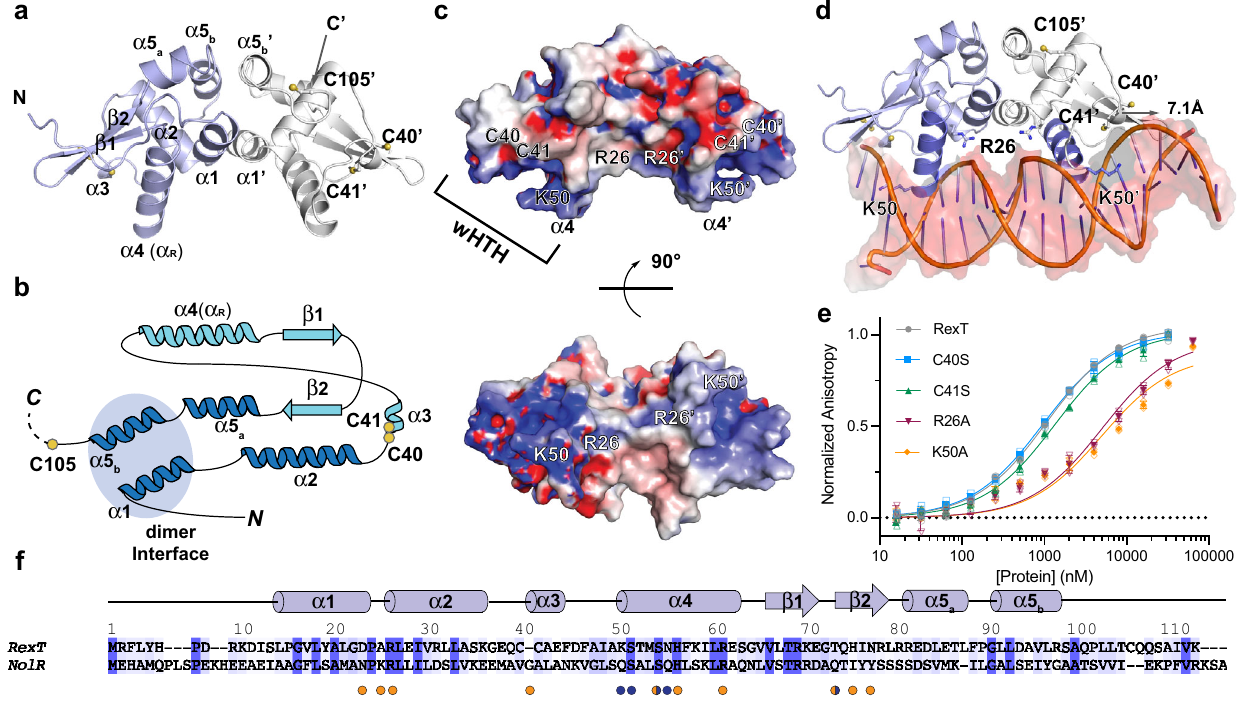
Fig. 2 RexT has an ArsR-SmtB-type winged helix-turn-helix fold. a The crystal structure of RexT reveals that it is a homodimer. Each protomer of RexT has an α 1- α 2- α 3- α 4- β 1- β 2- α 5 a/b architecture. Chains A and B are colored in light blue and light gray, respectively. Two of the three potential redox sensing Cys residues are located on the α 3 helix (Cys40 and Cys41). Due to the dynamic nature of the residues following Cys105 in chain B, residues 106 – 112, like residues 102 – 112 in chain A were unable to be included in the fi nal model of RexT. b A topology diagram of RexT shows the position of the three Cys residues (yellow circles), the dimeric interface (blue circle), and the wHTH motif (light blue secondary structure). c The calculated electrostatic potential of RexT reveals positively charged patches. The two-Cys residues and two positively charged residues that are proposed to be involved in DNA-binding are highlighted. d RexT is shown overlaid with a DNA-bound NolR structure 32 (PDB: 4ON0, RexT is shown with DNA from the NolR structure following an alignment performed in PyMol). This overlay reveals potential residues involved in interacting with DNA and showcases that a complementary interaction can be formed between the positively charged region of RexT and the negative backbone of DNA. In each monomer, α R is colored in dark purple. e A labeled DNA probe shows changes in fl uorescence anisotropy following the addition of RexT. These differences allowed for the calculation of the DNA binding af fi nity of wild-type RexT and the different variants used in this work (Supplementary Table 2). Compared to wild-type RexT (gray, K d = 1.08 ± 0.07 µ M), the K50A (orange, K d = 5.29 ± 1.86 µ M) and R26A (red, K d = 5.18 ± 1.22 µ M) RexT variants show decreased DNA binding af fi nity whereas the C40S (blue) and C41S (green) variants don ’ t have any signi fi cant change. f A sequence alignment of RexT with NolR shows a conserved DNA- binding architecture and key residues. The sequences are aligned by Clustal W. 89 and colored by Jalview 90 based on the percent identity with dark blue indicating sequence identity. DNA binding residues in NolR are indicated by orange (interaction with DNA backbone phosphate) and blue (base-speci fi c interaction) dots. The alignment is annotated based on the secondary structure and residue numbers of RexT. In e , data was measured using n = 3 independent experiments and is presented with the individual measurements (open shapes) and as the mean value of these measurements ± SD (closed shapes). Source data are provided as a Source Data fi